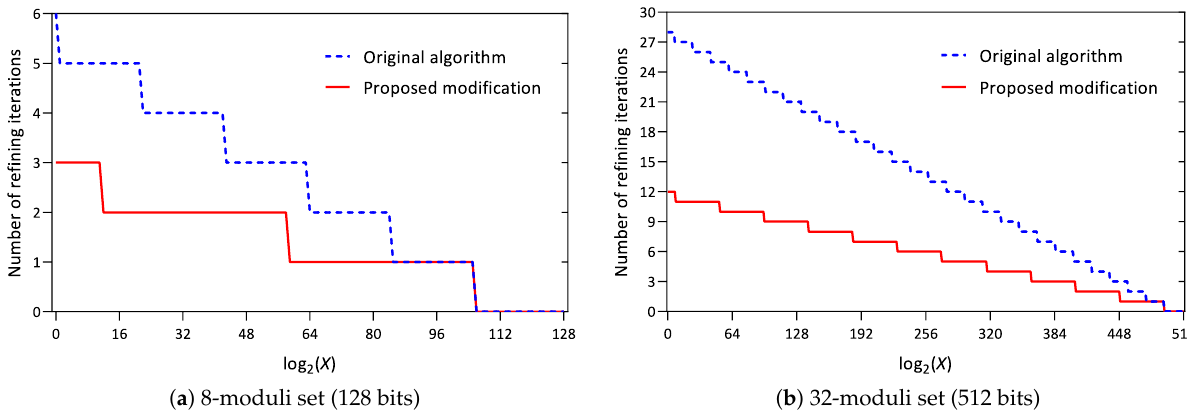
Figure 2. Number of iterations required to compute the interval evaluation of an RNS number with accuracy ε = 10 − 7 in 8- and 32-moduli sets using double precision floating-point